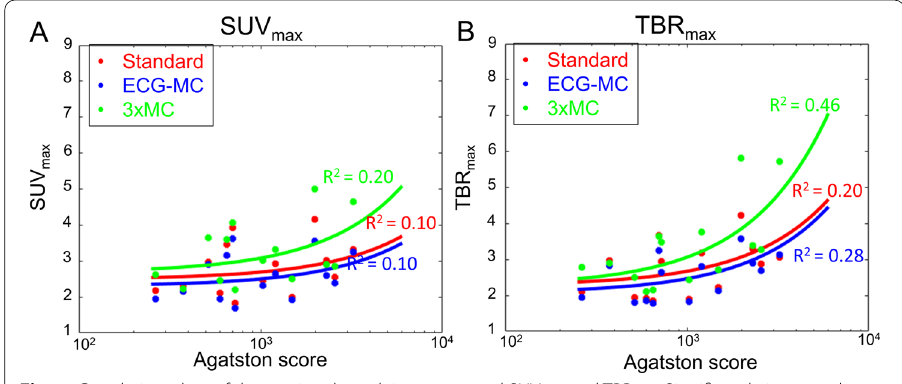
Fig. 4 Correlation plots of the aortic valve calcium score and SUV max and TBR max . Significantly improved correlations were observed for the 3 MC when compared to the other reconstructions for both SUV max ( A ) × and TBR max ( B ). Of note, the repeated measurements were averaged for the plots. Standard imaging, ECG-MC ECG motion-corrected, 3 MC triple motion-corrected. SUV max = × = uptake value, TBR max